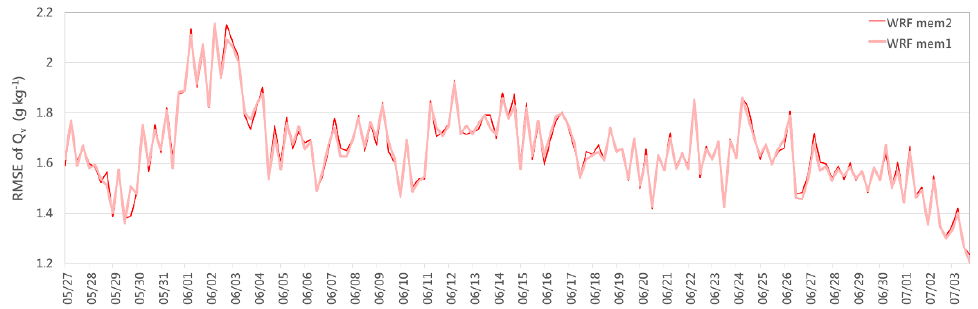
Figure 8. The root-mean-square error of the predicted 850-hPa water vapor mixing ratio at 24 h in Domain 2 for the 152 forecasts initialized during 00:00 UTC 26 May–18:00 UTC 2 July 2020, for WRF Members 1 (pink curves) and 2 (red curves).